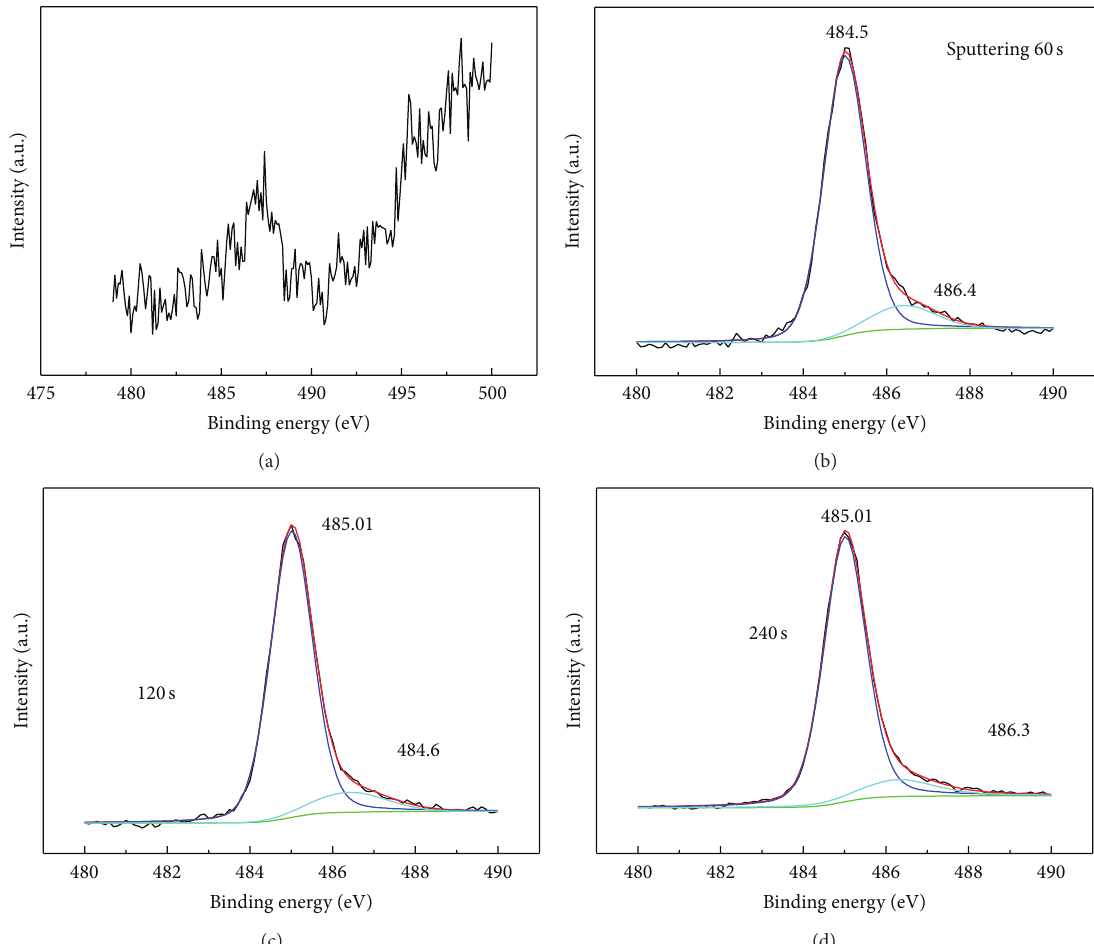
Figure 4: Sn 3d5/2 spectra of SBZ sample exposure at 170 ∘ C for 7min after etching for (a) 0s (initial surface), (b) 10s, (c) 140 s, and (d) 260 s.